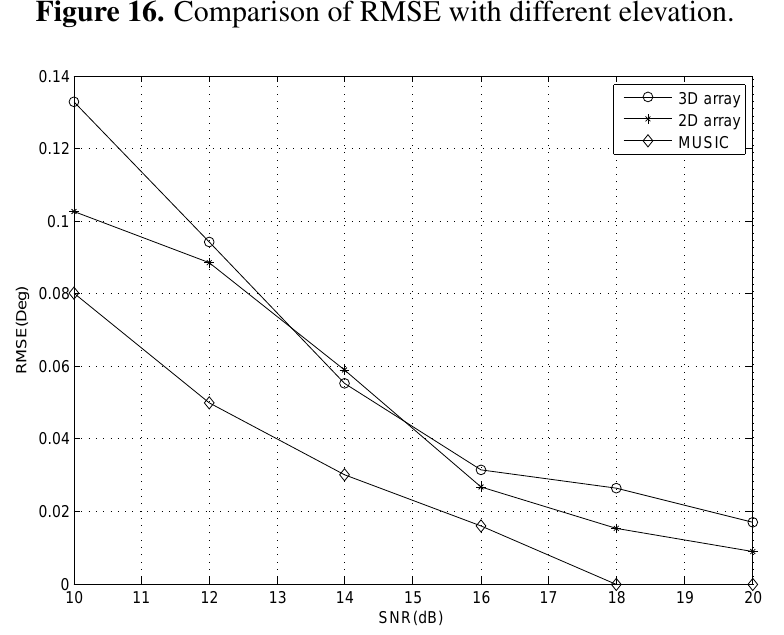
Figure 16. Comparison of RMSE with different elevation.